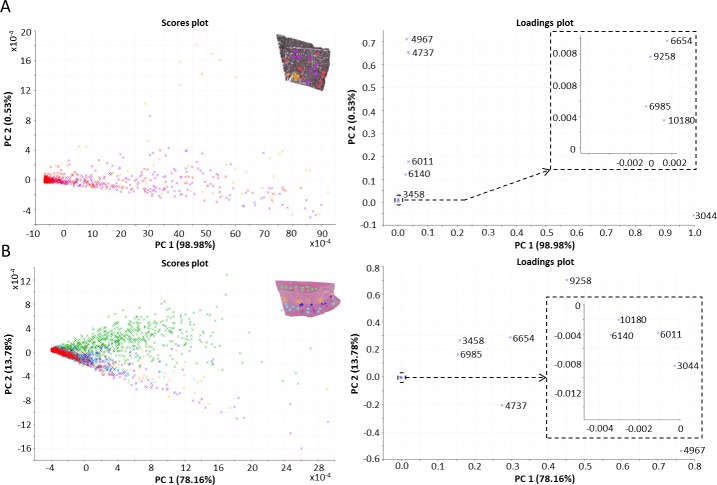
A) PCA scores and loadings plots of three histologically differentiated regions of MeLiM melanoma (inset). Red–normally growing melanoma tissue (GMT), violet–early spontaneous regression (ESR), and orange–late spontaneous regression (LSR). B) PCA scores and loadings plots of six ROIs in healthy skin tissue (inset). Red–epidermis, light blue–dermis, violet—hair follicle, dark blue–sweat gland, orange–subcutaneous adipose tissue, and green–subcutaneous muscle.